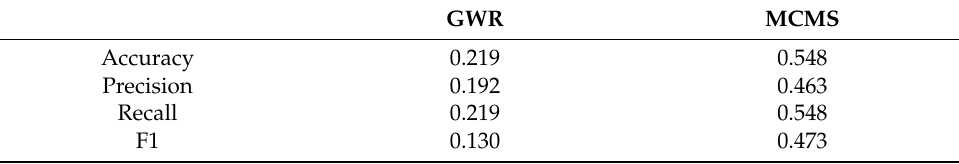
Figure 5. Comparison results of each layer of the proposed MCMS and GWR: ( a ) episodic memory layer; ( b ) semantic memory layer. Table 4. Comparison results between the proposed MCMS and GWR (context = 2) by using all classes of data.